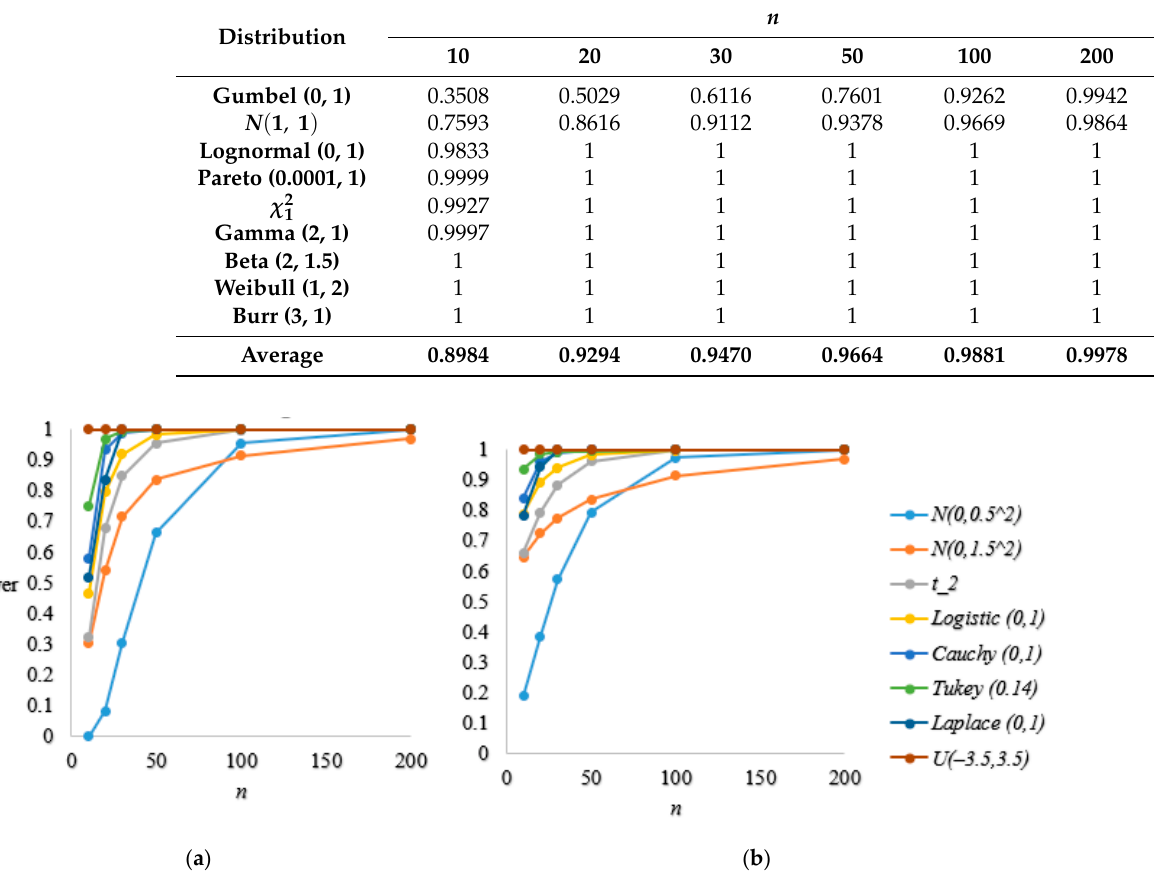
Figure 6. Empirical power of statistic 𝑉(cid:3364) (cid:3041) for various sample sizes with the level of significance 𝛼 = 0.05 —Symmetric alternative distributions: ( a ) Parameters 𝜇 and 𝜎 (cid:2870) are known; ( b ) Parameters 𝜇 and 𝜎 (cid:2870) are estimated with 𝑋(cid:3364) (cid:3041) and 𝑆(cid:4634) (cid:3041)(cid:2870) , respectively.